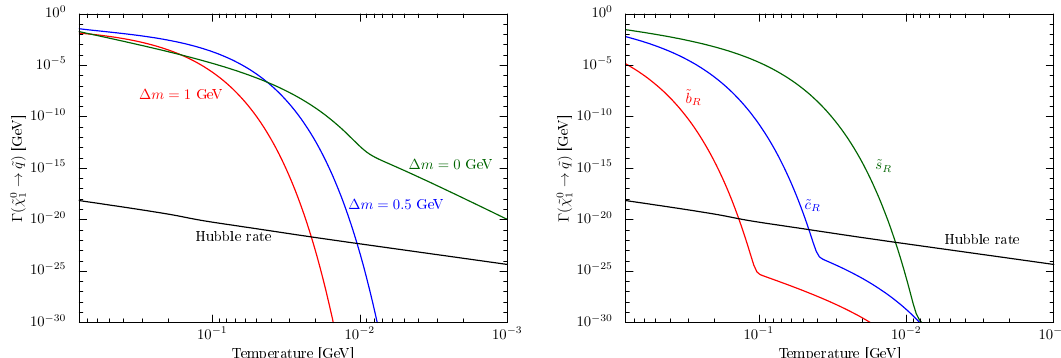
(a) Scalar up quark with (cid:1) m = 0, 0.5 and (b) Heavy (cid:13)avor scalar quark with (cid:1) m = 0 GeV. 1 GeV. Figure 4. Conversion rates between the bino LSP and scalar right-handed quark NLSP. (a): scalar up quark. The green, blue and red lines represent the cases of the mass di(cid:11)erence between the NLSP and LSP (cid:1) m being 0, 0.5, and 1 GeV, respectively. (b): heavy (cid:13)avor scalar quark with (cid:1) m = 0 GeV and minimal (cid:13)avor violation. The green, blue and red lines represent the cases of ~ s R , ~ c R and ~ b R , respectively.